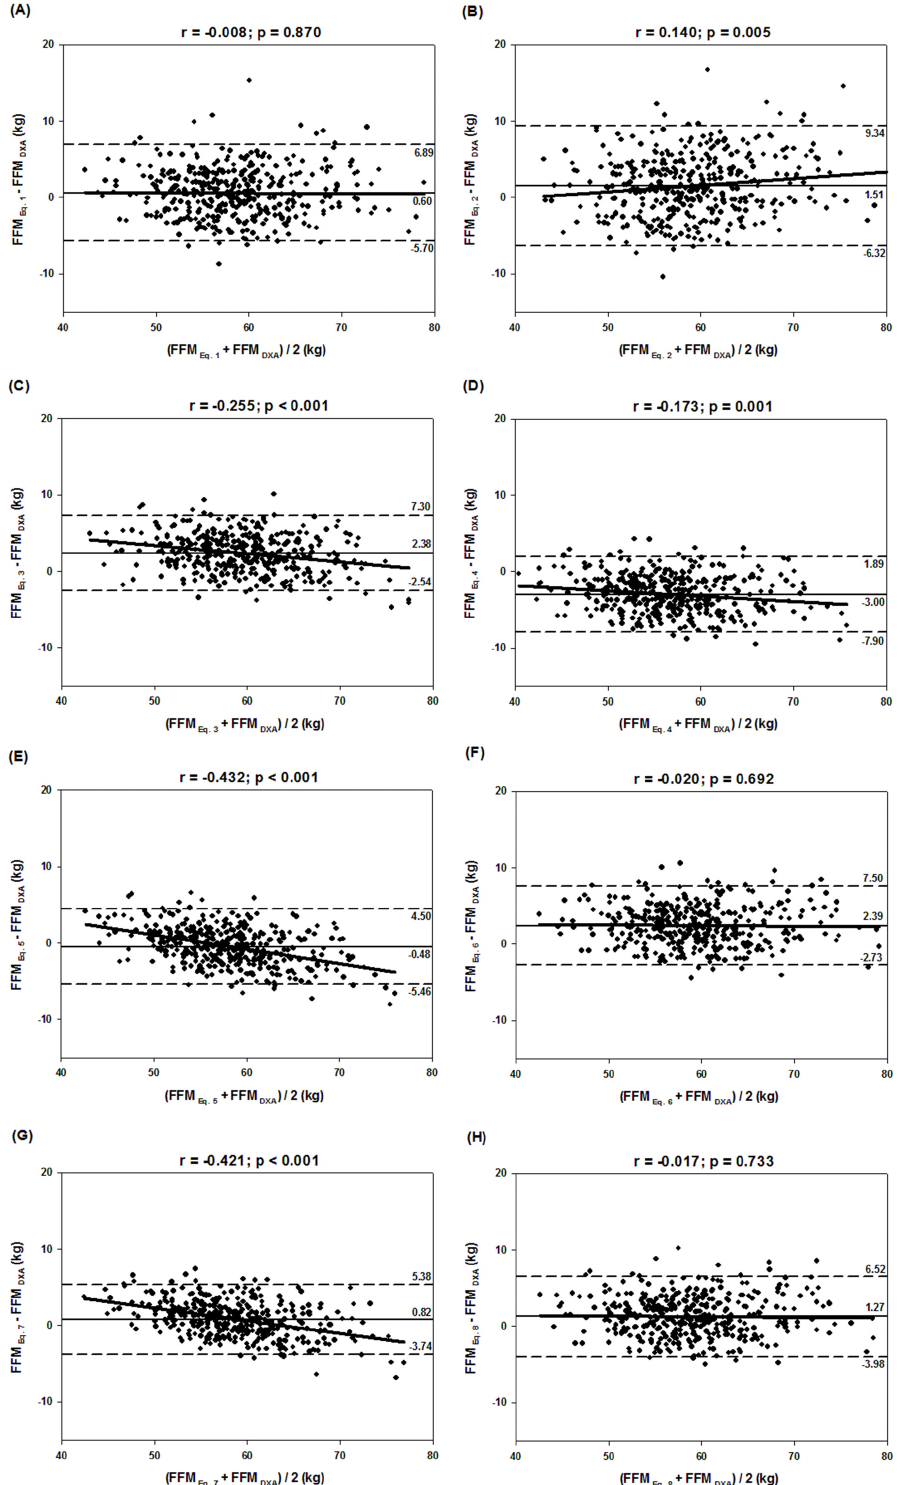
Figure 1. Bland–Altman plots of the agreement between values of FFM determined by the reference method (DXA) and estimated by BIA equations in the sample of cadets ( n = 396): ( A ) Equation (1) [13]; ( B ) Equation (2) [14]; ( C ) Equation (3) [15]; ( D ) Equation (4) [16]; ( E) Equation (5) [17]; ( F ) Equation (6) [18]; ( G ) Equation (7) [19]; ( H ) Equation (8) [20]. Solid black line: mean of the differences; dashed line: limits of agreement of 95%; continuous gray line: correlation ( r ) between the average and the differences of the